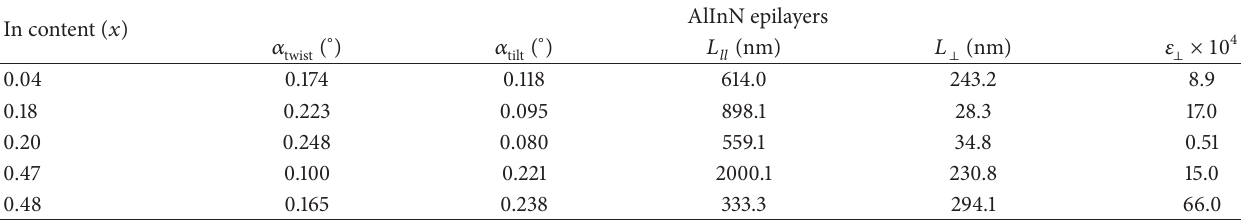
Table 3: The calculated mosaic structures parameters of the AlInN epilayers that were grown on GaN/sapphire structures, including the , mean tilt angle, 𝛼 , lateral coherence length, 𝐿 𝑙𝑙 , vertical coherence length, 𝐿 ⊥ , and vertical heterogeneous strain, 𝜀 ⊥ mean twist angle, 𝛼 twist tilt are